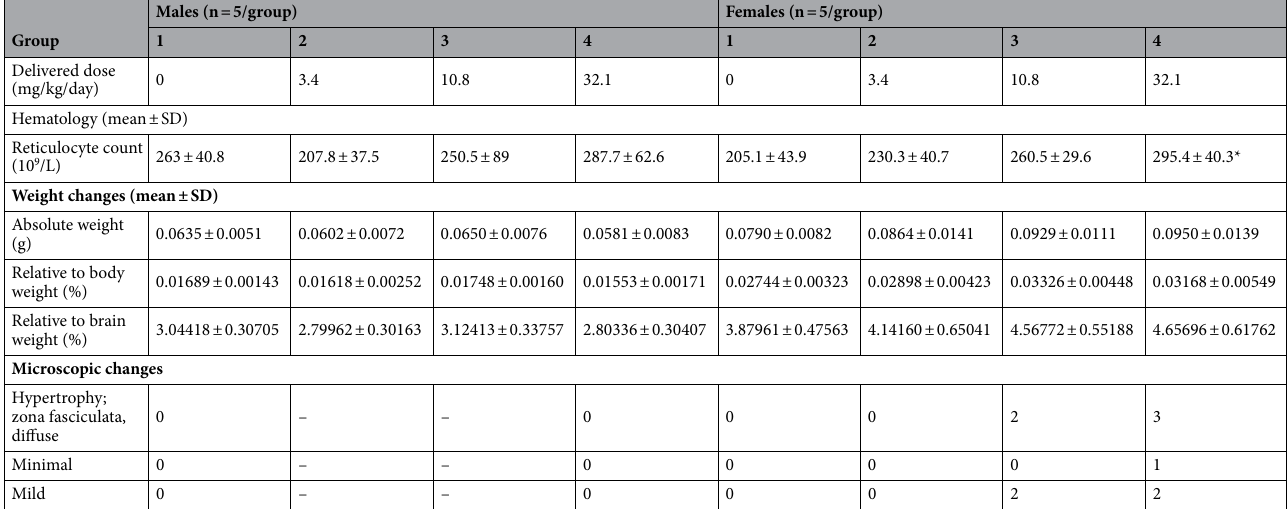
Table 4. Group mean reticulocyte count, adrenal gland weight and microscopic changes after dosing of PCCR-1. *P ≤